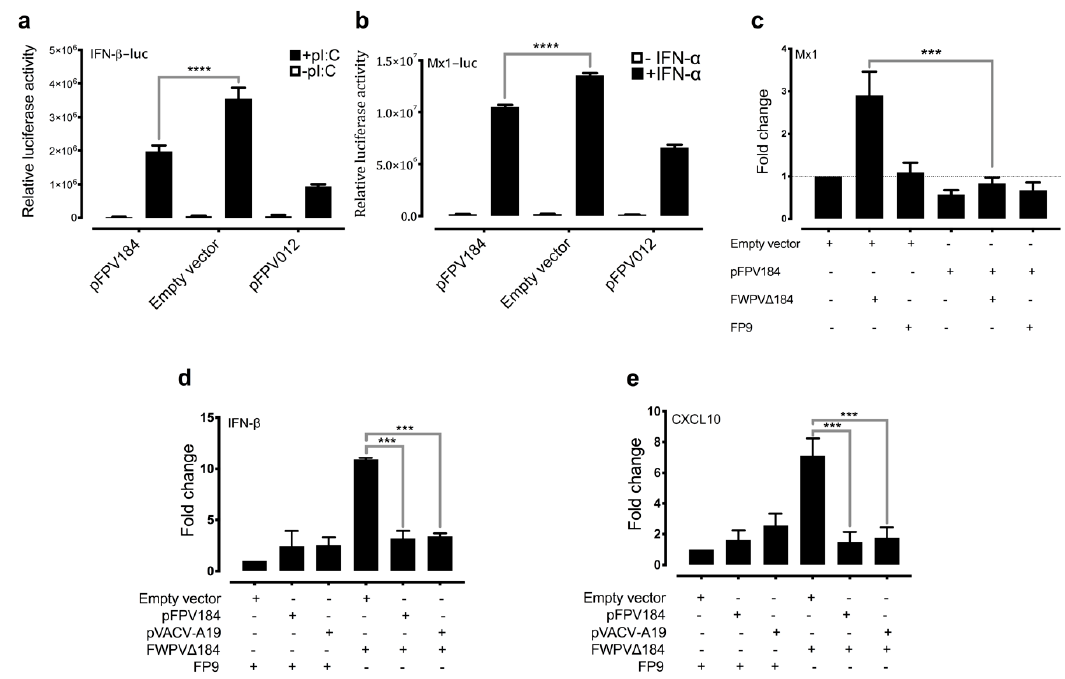
Figure 4. Ectopic expression of FPV184 elicits an immunomodulatory e ff ect in chicken and human cells. Using a luciferase assay, the FLAG-tagged FPV184 protein was shown to inhibit the induction of both chicken IFN- β promoter (IFN- β -luc) by polyI:C ( a ) and, to a lesser extent, the chicken Mx1 promoter (Mx1-luc) by IFN- α ( b ) in chicken DF-1 cells. Data are presented as relative luciferase activity. Two-way ANOVA (type of plasmid and e ff ect of IFN- α or pI:C) with Bonferroni’s posthoc test was used to analyse the data (**** p < 0.0001). ( c ) Complementation assay measuring Mx1 induction by qRT-PCR in DF-1 cells transiently transfected (48 h) with either the FPV184 expression plasmid or with the empty vector and infected with FWPV ∆ 184 or FP9 for 4 h (MOI: 5). One-way ANOVA with Tukey’s posthoc test was used to analyse the data (*** p < 0.001). ( d ) qPCR analysis of human IFN- β and ( e ) human CXCL10 mRNA levels in HEK293T cells transfected for 48 h with either an expression plasmid for FPV184 or VACV A19 and infected with parental FP9 or FWPV ∆ 184 for 4 h (MOI: 5). Error bars indicate SEM; n = 3. One-way ANOVA with Dunnett’s posthoc test was used to analyse the data. *** p < 0.001. ( c–e ) Results shown are representative of three independent experiments and show fold change in mRNA expression of genes compared to mock-transfected samples. Confirmation of transfections with qPCR for mRNA levels of FPV184 and VACV A19 is presented in Figure S5.